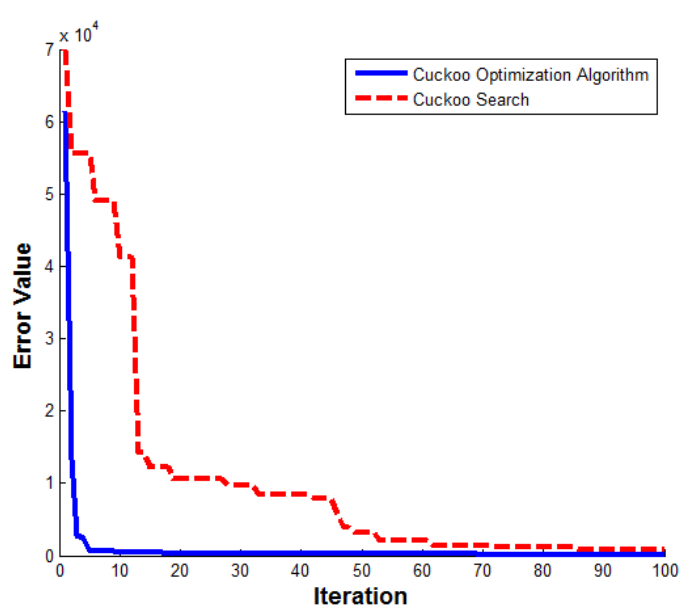
Figure 5. Sum squared error values in 100